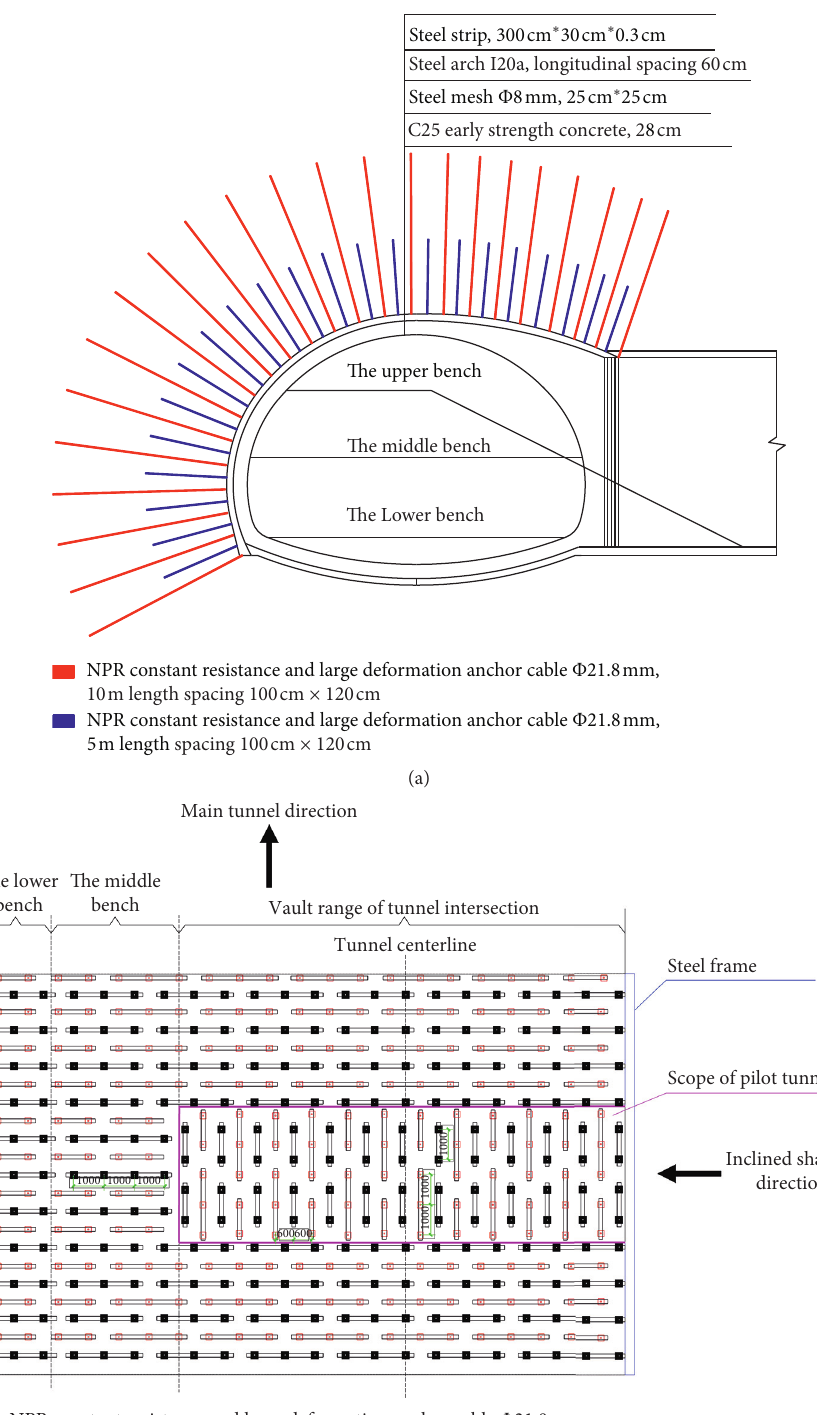
Figure 18: Constant resistance support scheme of tunnel intersection. (a) Cross section of the tunnel supported by the NPR anchor cable. (b) Tunnel annular arrangement of the NPR anchor